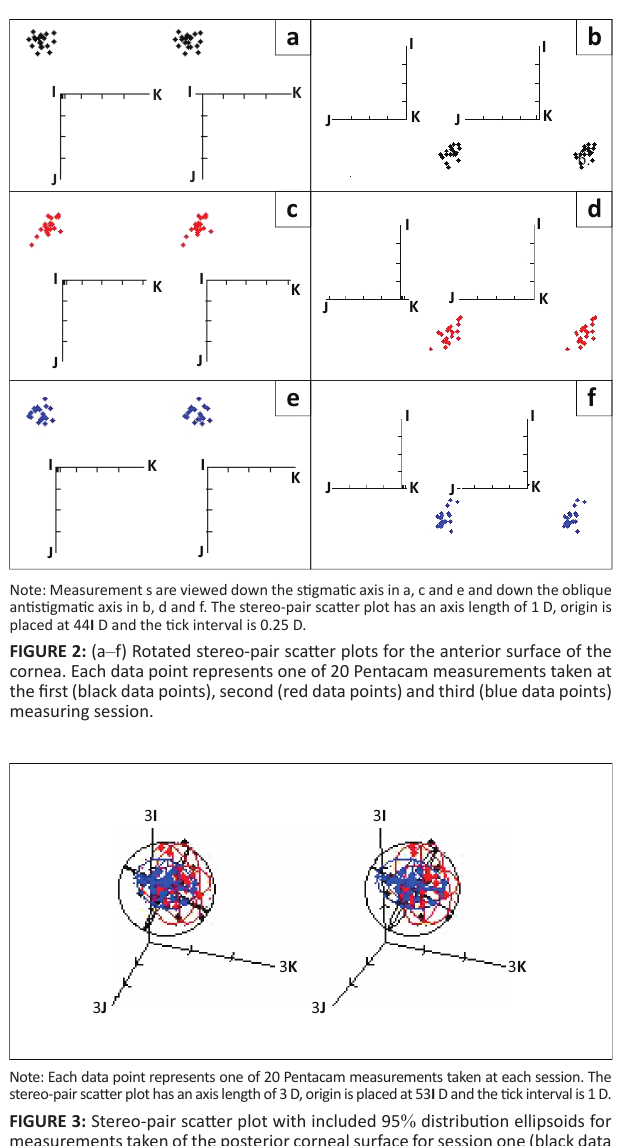
Note: Each data point represents one of 20 Pentacam measurements taken at each session. The stereo-pair scatter plot has an axis length of 1 D, origin is placed at 44 I D and the tick interval is 0.25 D. FIGURE 1: Stereo-pair scatter plot with included 95 % distribution ellipsoids for measurements taken of the anterior corneal surface for session one (black data points), session two (red data points) and session three (blue data points).